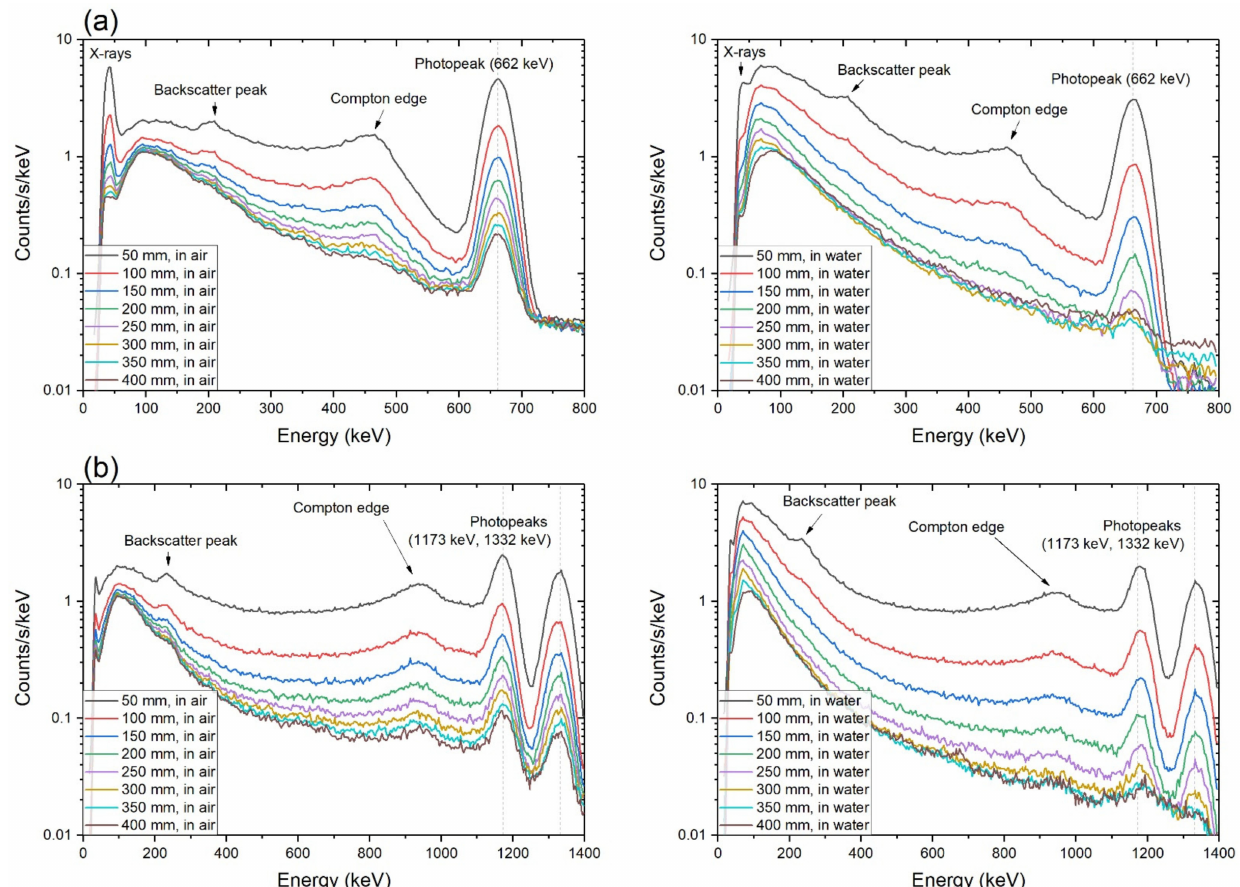
Figure 11. Gamma-ray spectra of ( a ) Cs-137 and ( b ) Co-60 obtained at 50–400 mm distances in air and in water for 300 s.